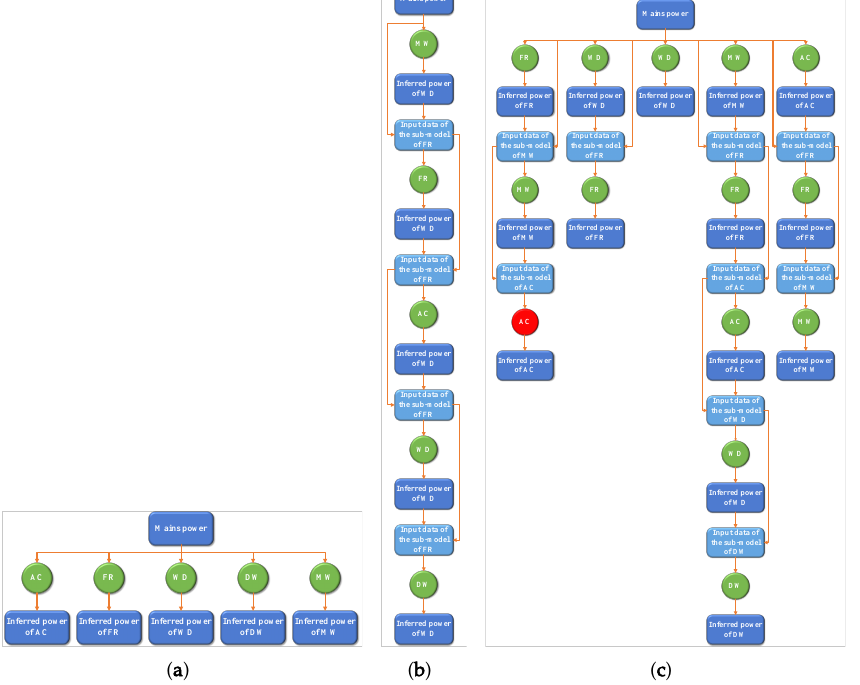
Figure 1. Schematic diagram of three energy disaggregation methods. ( a ) Independent method; ( b ) SC-NILM; ( c ) MC-NILM. (AC: Air conditioner, FR: Fridge freezer, WD: Wash dryer, DW: Dish washer, MW: Microwave)